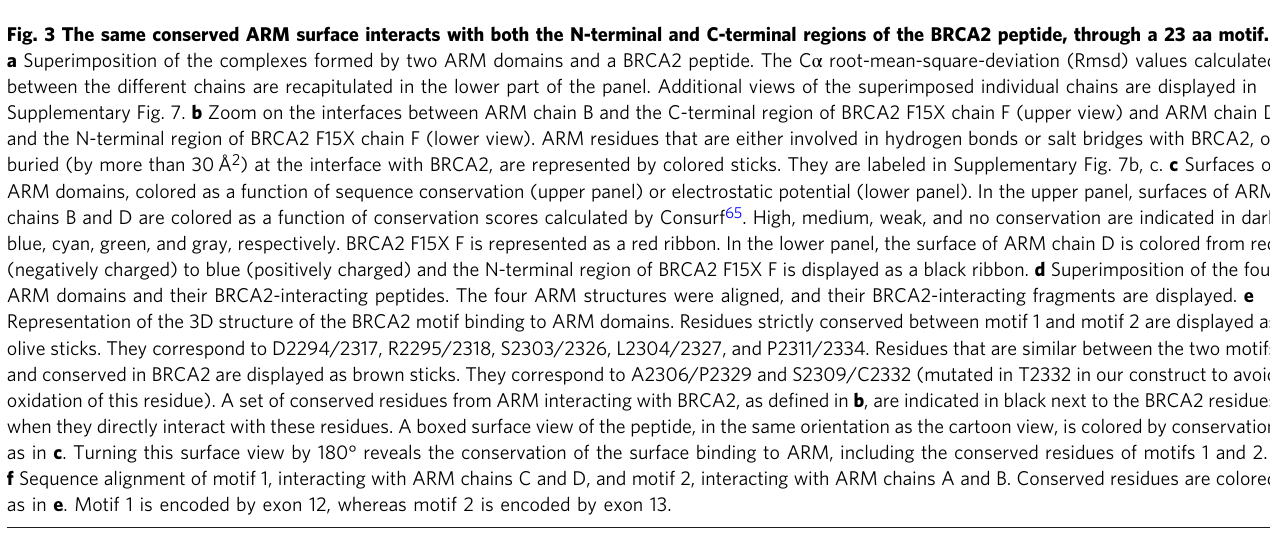
Fig. 3 The same conserved ARM surface interacts with both the N-terminal and C-terminal regions of the BRCA2 peptide, through a 23 aa motif. a Superimposition of the complexes formed by two ARM domains and a BRCA2 peptide. The C α root-mean-square-deviation (Rmsd) values calculated between the different chains are recapitulated in the lower part of the panel. Additional views of the superimposed individual chains are displayed in Supplementary Fig. 7. b Zoom on the interfaces between ARM chain B and the C-terminal region of BRCA2 F15X chain F (upper view) and ARM chain D and the N-terminal region of BRCA2 F15X chain F (lower view). ARM residues that are either involved in hydrogen bonds or salt bridges with BRCA2, or buried (by more than 30 Å 2 ) at the interface with BRCA2, are represented by colored sticks. They are labeled in Supplementary Fig. 7b, c. c Surfaces of ARM domains, colored as a function of sequence conservation (upper panel) or electrostatic potential (lower panel). In the upper panel, surfaces of ARM chains B and D are colored as a function of conservation scores calculated by Consurf 65 . High, medium, weak, and no conservation are indicated in dark blue, cyan, green, and gray, respectively. BRCA2 F15X F is represented as a red ribbon. In the lower panel, the surface of ARM chain D is colored from red (negatively charged) to blue (positively charged) and the N-terminal region of BRCA2 F15X F is displayed as a black ribbon. d Superimposition of the four ARM domains and their BRCA2-interacting peptides. The four ARM structures were aligned, and their BRCA2-interacting fragments are displayed. e Representation of the 3D structure of the BRCA2 motif binding to ARM domains. Residues strictly conserved between motif 1 and motif 2 are displayed as olive sticks. They correspond to D2294/2317, R2295/2318, S2303/2326, L2304/2327, and P2311/2334. Residues that are similar between the two motifs and conserved in BRCA2 are displayed as brown sticks. They correspond to A2306/P2329 and S2309/C2332 (mutated in T2332 in our construct to avoid oxidation of this residue). A set of conserved residues from ARM interacting with BRCA2, as de fi ned in b , are indicated in black next to the BRCA2 residues when they directly interact with these residues. A boxed surface view of the peptide, in the same orientation as the cartoon view, is colored by conservation as in c . Turning this surface view by 180° reveals the conservation of the surface binding to ARM, including the conserved residues of motifs 1 and 2. f Sequence alignment of motif 1, interacting with ARM chains C and D, and motif 2, interacting with ARM chains A and B. Conserved residues are colored as in e . Motif 1 is encoded by exon 12, whereas motif 2 is encoded by exon